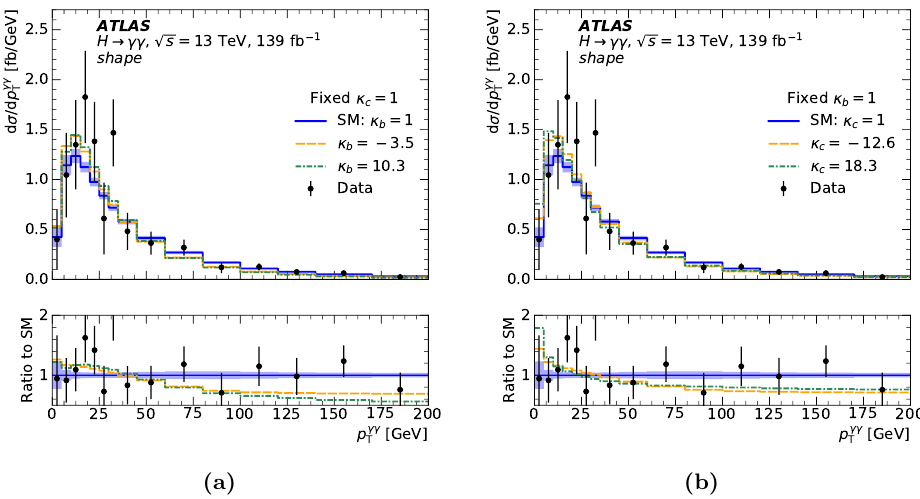
compared T and (b) κ corresponding to the upper (in green) b c